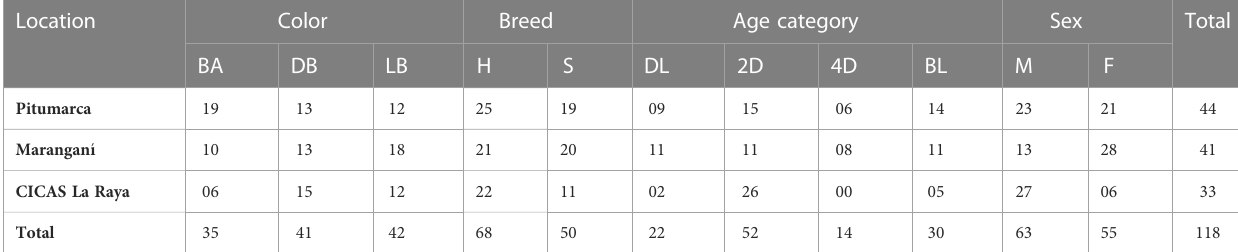
TABLE 1 Number ( n ) of alpacas sampled according to color, breed, age, and sex from Pitumarca, Marangan ı ́ , and CICAS La Raya (Cusco, Peru).